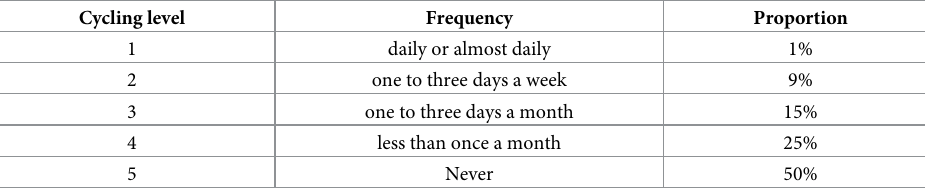
Table 1. ‘Pre-construction’ cycling levels in the local population subset (N = 173,169). Cycling level Frequency